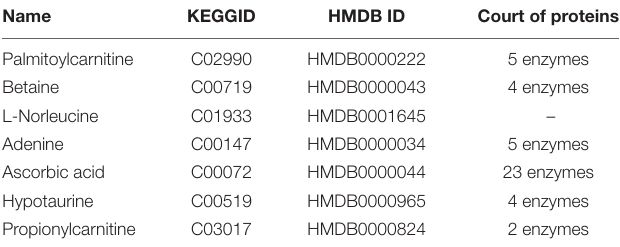
TABLE 4 | Different metabolites in hippocampal traumatic brain injury and related proteins revealed by the Human Metabolome Database analysis.